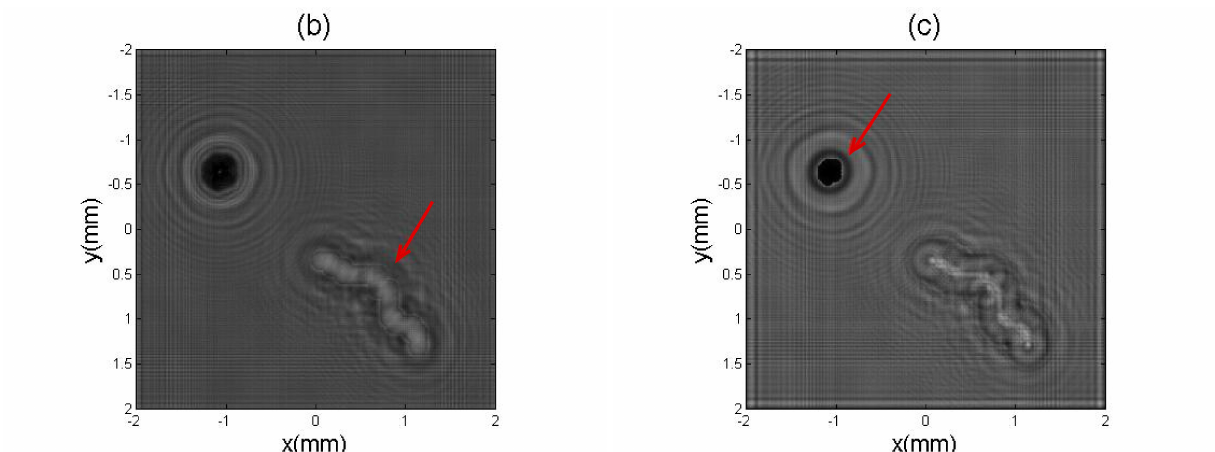
Figure 4. ( a ) Simulated hologram considering both phase and opaque objects located in two different planes; ( b ) Reconstructed phase object with optimal order α opt